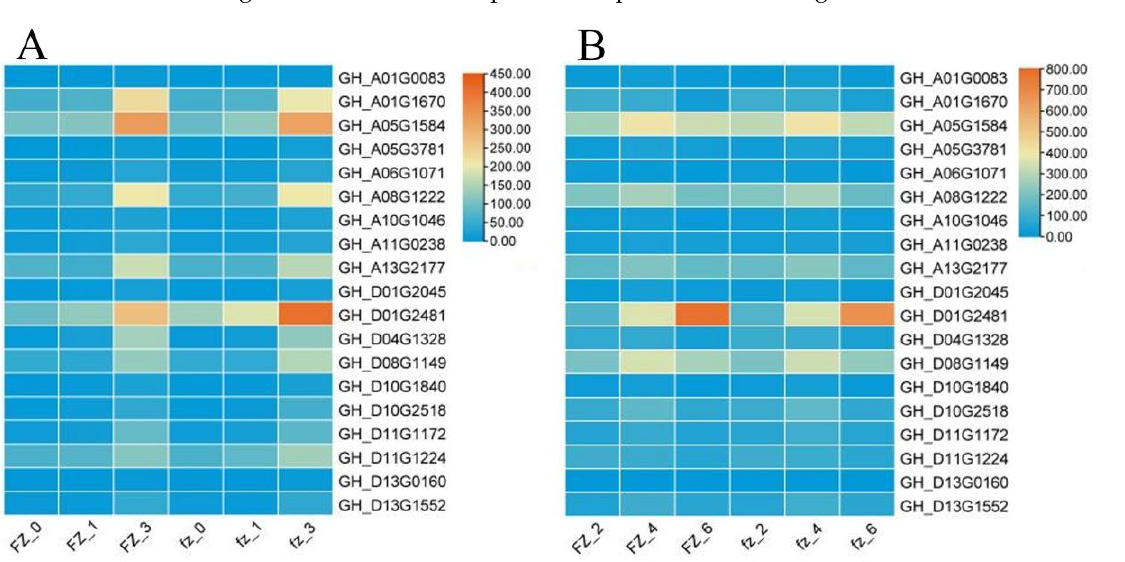
Figure 13. Analysis of hub gene expression: ( A ) Xinluzao 50 and Xinluzao 50 expression heatmaps; ( B ) CSS386 and Sicala V-2 expression heatmaps. FZ, fuzzless material; fz, fuzz material. As can be seen from the figure, the expression levels of the genes GH_A01G1670 , GH_A05G1584 , GH_A08G1222 , and GH_D01G2481 were higher than those of other genes in the +3 DPA stage of Xinluzao 50 and its mutant Xinluzao 50